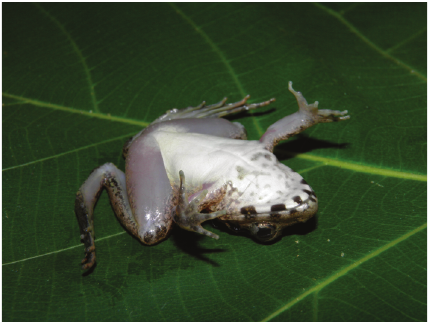
Figure 2: Feigning death behaviour demonstrated by L. blythii .